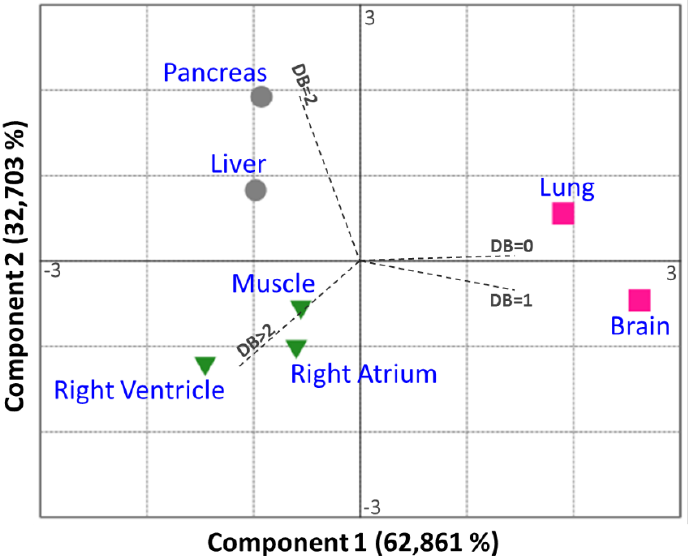
Figure 3. Principal component analyses (PCA) of the variability in PC DB index as a function of the organ. The variables measured in this study (i.e., DB = 0, DB = 1, DB = 2, and DB > 2) are expressed as vectors in dashed lines.